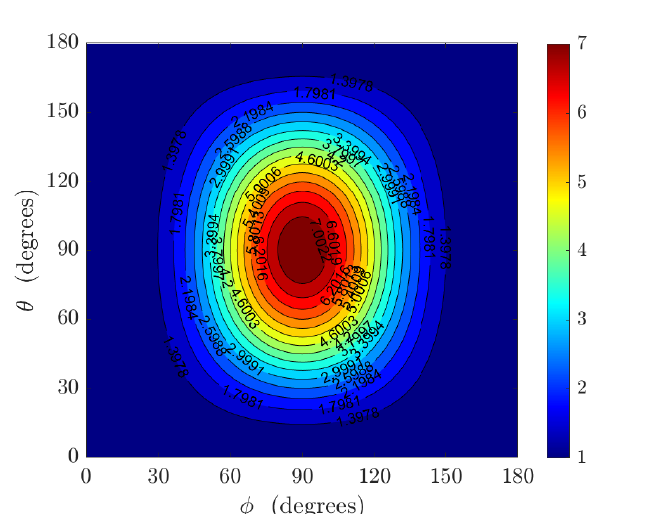
∈ [ 0,1 ◦ ] , both for K = 100 samples, ψ